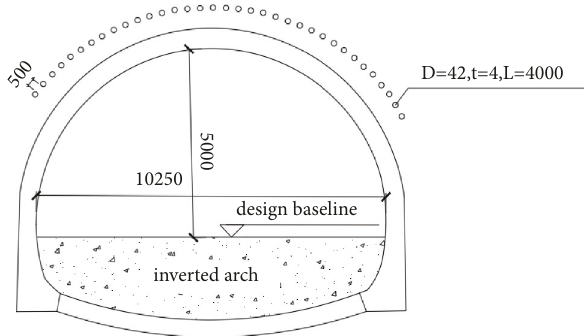
Figure 12: Original design scheme. Unit: